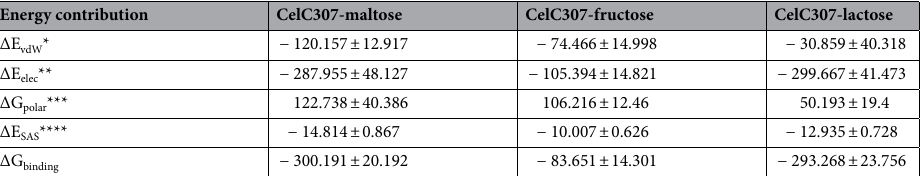
Table 1. Binding free energies and their corresponding components, obtained from MM/PBSA analysis of the CelC307 complexes with maltose, lactose, and fructose. All values are in kJ/mol. *ΔE vdW van der